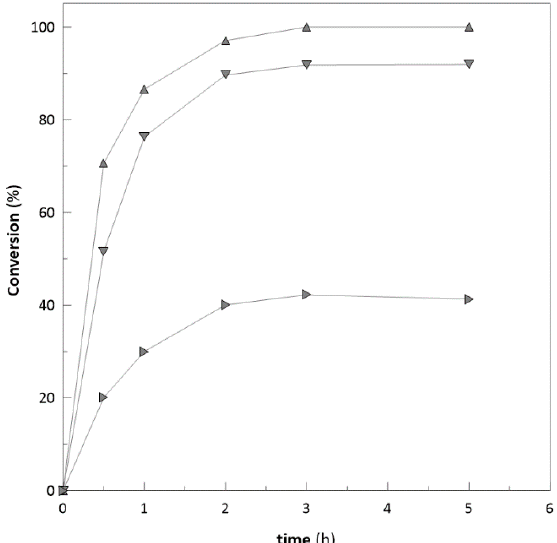
Figure 3. Achieved substrate conversion with different initial substrate concentrations (3 ′ - hydroxyacetophenone: ▲ 20 mM; ▼ 50 mM; ► 100 mM).